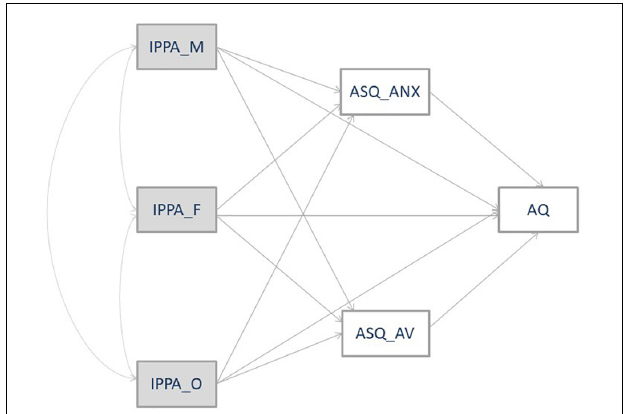
FIGURE 1 | Hypothetical model. Dependent variables: Aggression (AQ), Anxiety Attachment Style (ASQ_ANX), and Avoidance Attachment Style (ASQ_ANX). Independent variables: Maternal Attachment (IPPA_M), Paternal Attachment (IPPA_F), and Close Friend Attachment